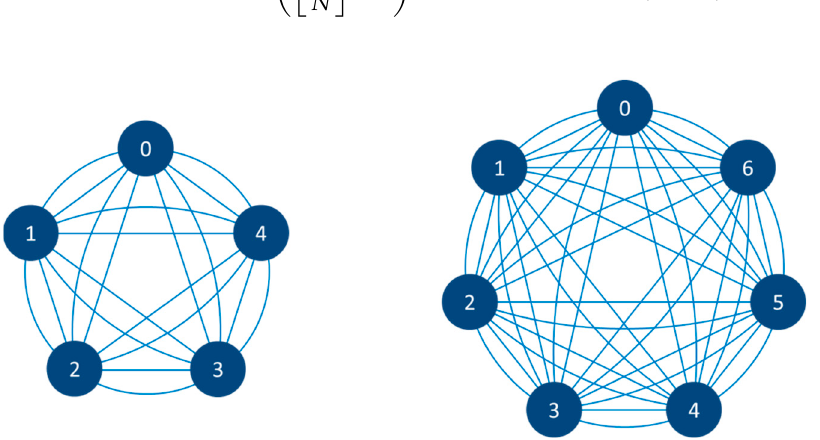
Figure 7. The Eulerian circuit for generating a waveform sequence, where the vertices represent distinct waveforms, and the edges represent the transitions among them.